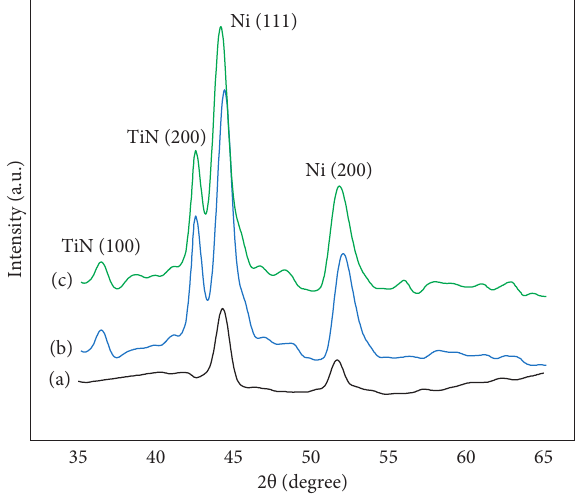
Figure 2: GIXRD patterns of nanocrystalline: (a) Ni, (b) Ni-TiN, and (c) Ni